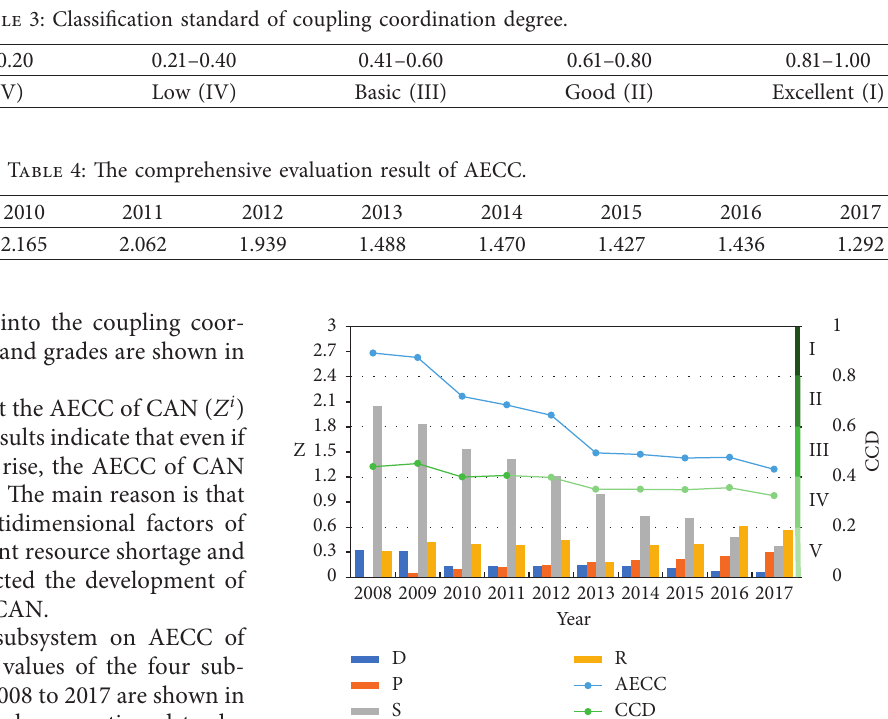
Figure 3: The changes of each subsystem from 2008 to 2017.